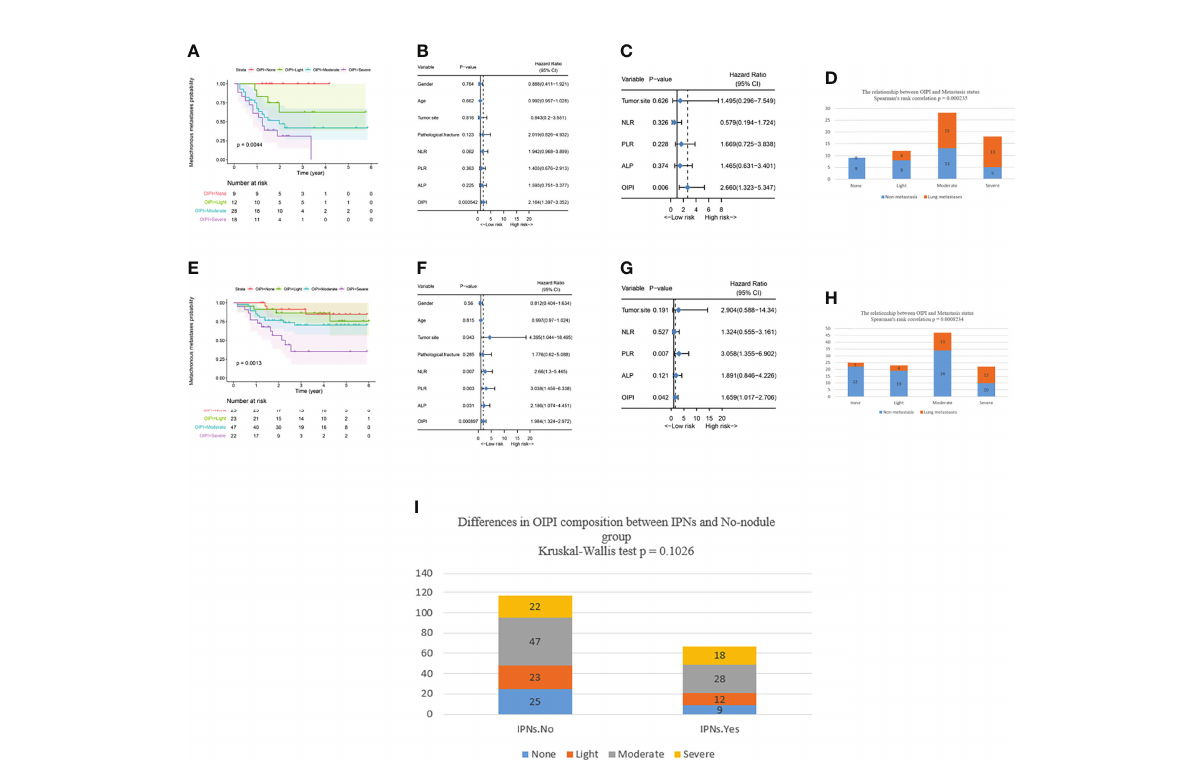
FIGURE 3 Effect of the OIPI in predicting metachronous metastasis in patients with no nodule or IPNs. (A) OIPI divided 67 patients with IPNs into four groups. There are signi fi cant differences among patients in the four groups (P = 0.0044). (B) Forest plot showing the results of univariate Cox regression analysis of hematological markers and clinical features in 67 patients with IPNs. (C) Forest plot showing the results of multivariate Cox regression analysis of hematological markers and clinical features in 67 patients with IPNs. (D) Spearman ’ s rank correlation test demonstrated that the OIPI was related to metastasis site in patients with IPNs (P = 0.000235). (E) OIPI divided 117 patients with no nodule into four groups. There were signi fi cant differences among patients in the four groups (P = 0.0013) (F) Forest plot showing the results of univariate COX regression analysis of hematological markers and clinical features in 117 patients with no nodule. (G) Forest plot showing the results of multivariate Cox regression analysis of hematological markers and clinical features in 117 patients with no nodule. (H) Spearman ’ s rank correlation test demonstrated that the OIPI was related to metastasis site in patients with no nodule (P = 0.0008234). (I) The Kruskal – Wallis test showed that there was no signi fi cant difference in the composition of OIPI between the IPN group and the no-nodule group. OIPI, osteosarcoma immune prognostic index; IPNs, indeterminate pulmonary nodules; NLR, neutrophil – lymphocyte ratio; PLR, platelet – lymphocyte ratio; ALP, alkaline